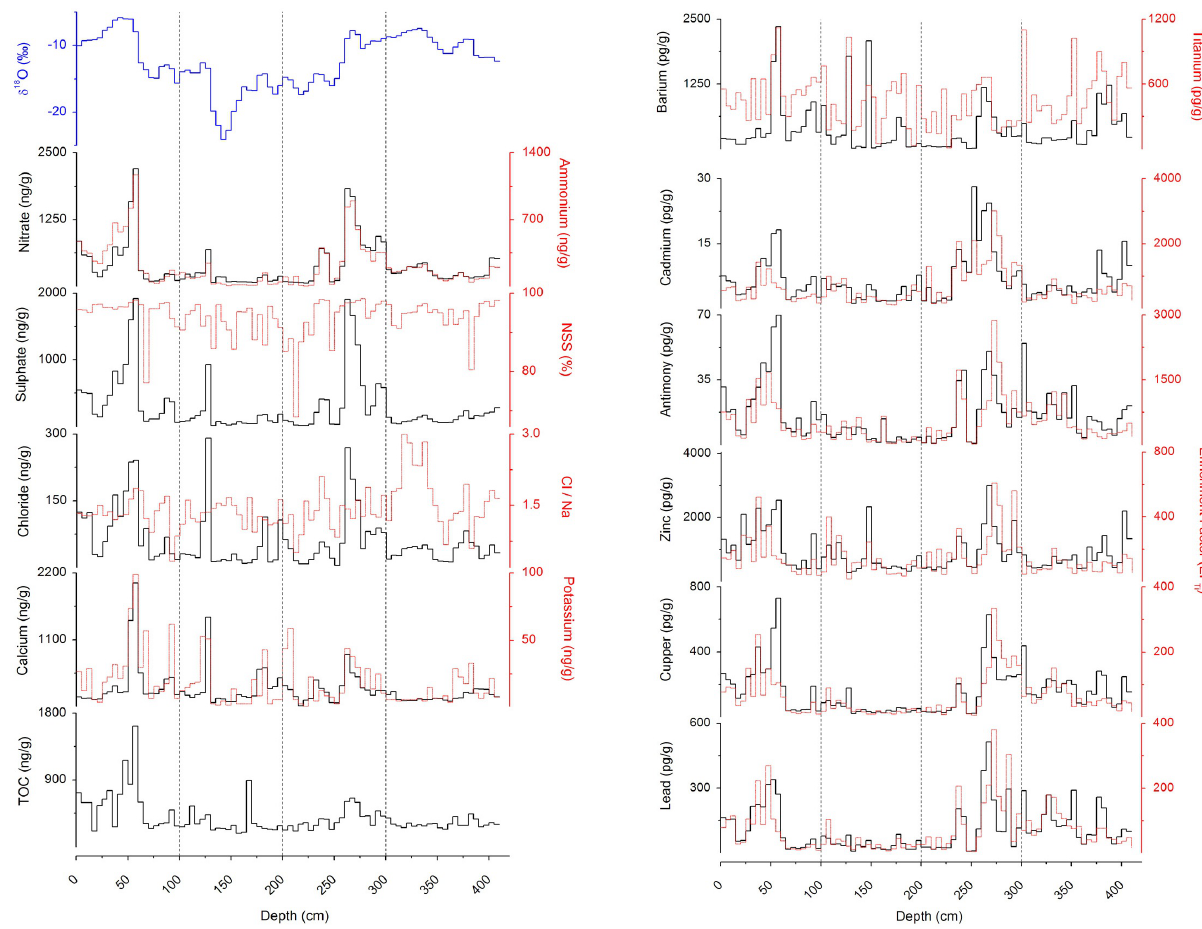
Fig. 4. Depth profiles of δ 18 O, major ions concentrations, TOC (a) and of some selected trace elements, and relative enrichment factors (b) in snow samples from the 4.2m snow pit on the Alto dell’Ortles